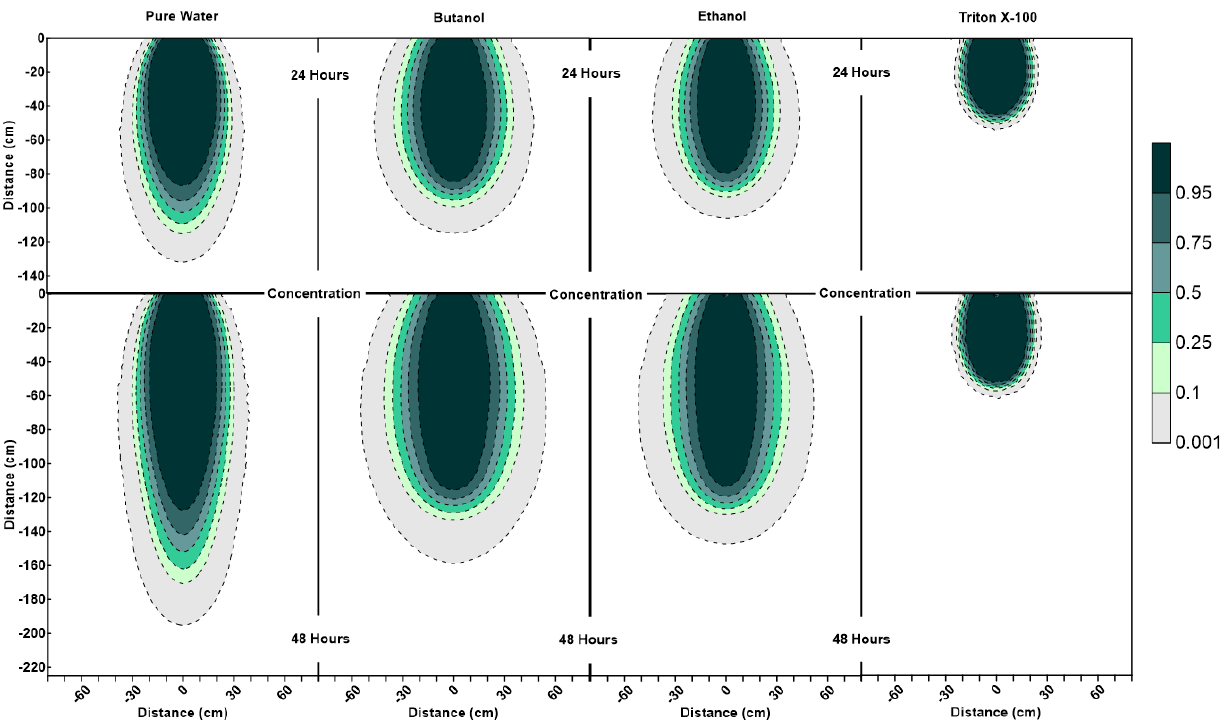
Figure 5. Concentration profiles (for relative concentrations of 1.0) at 24 h and 48 h for pure water, butanol, ethanol and Triton X ‐ 100 solutions.